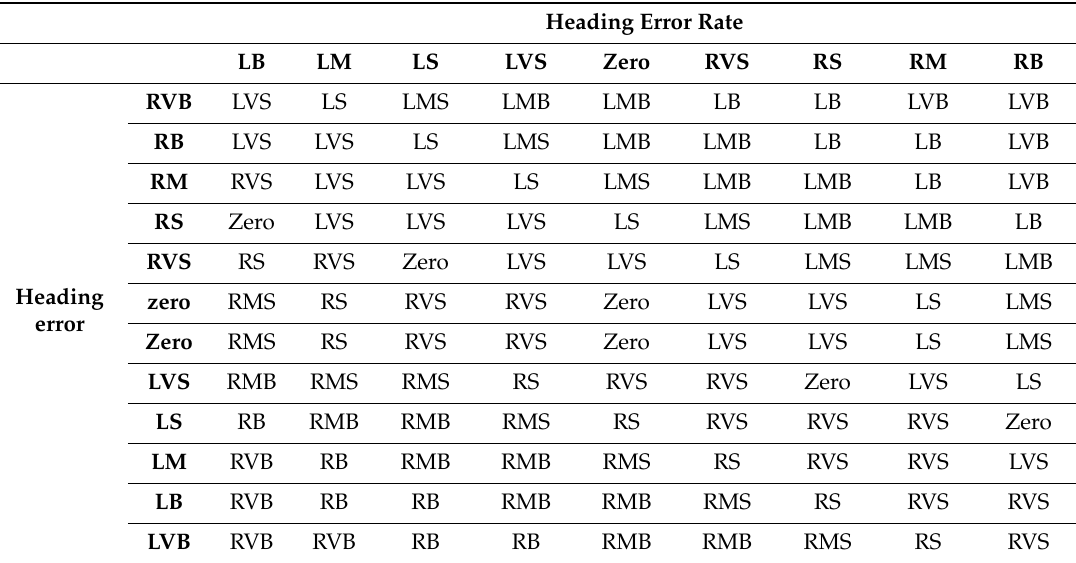
Table 1. Fuzzy rule database for heading